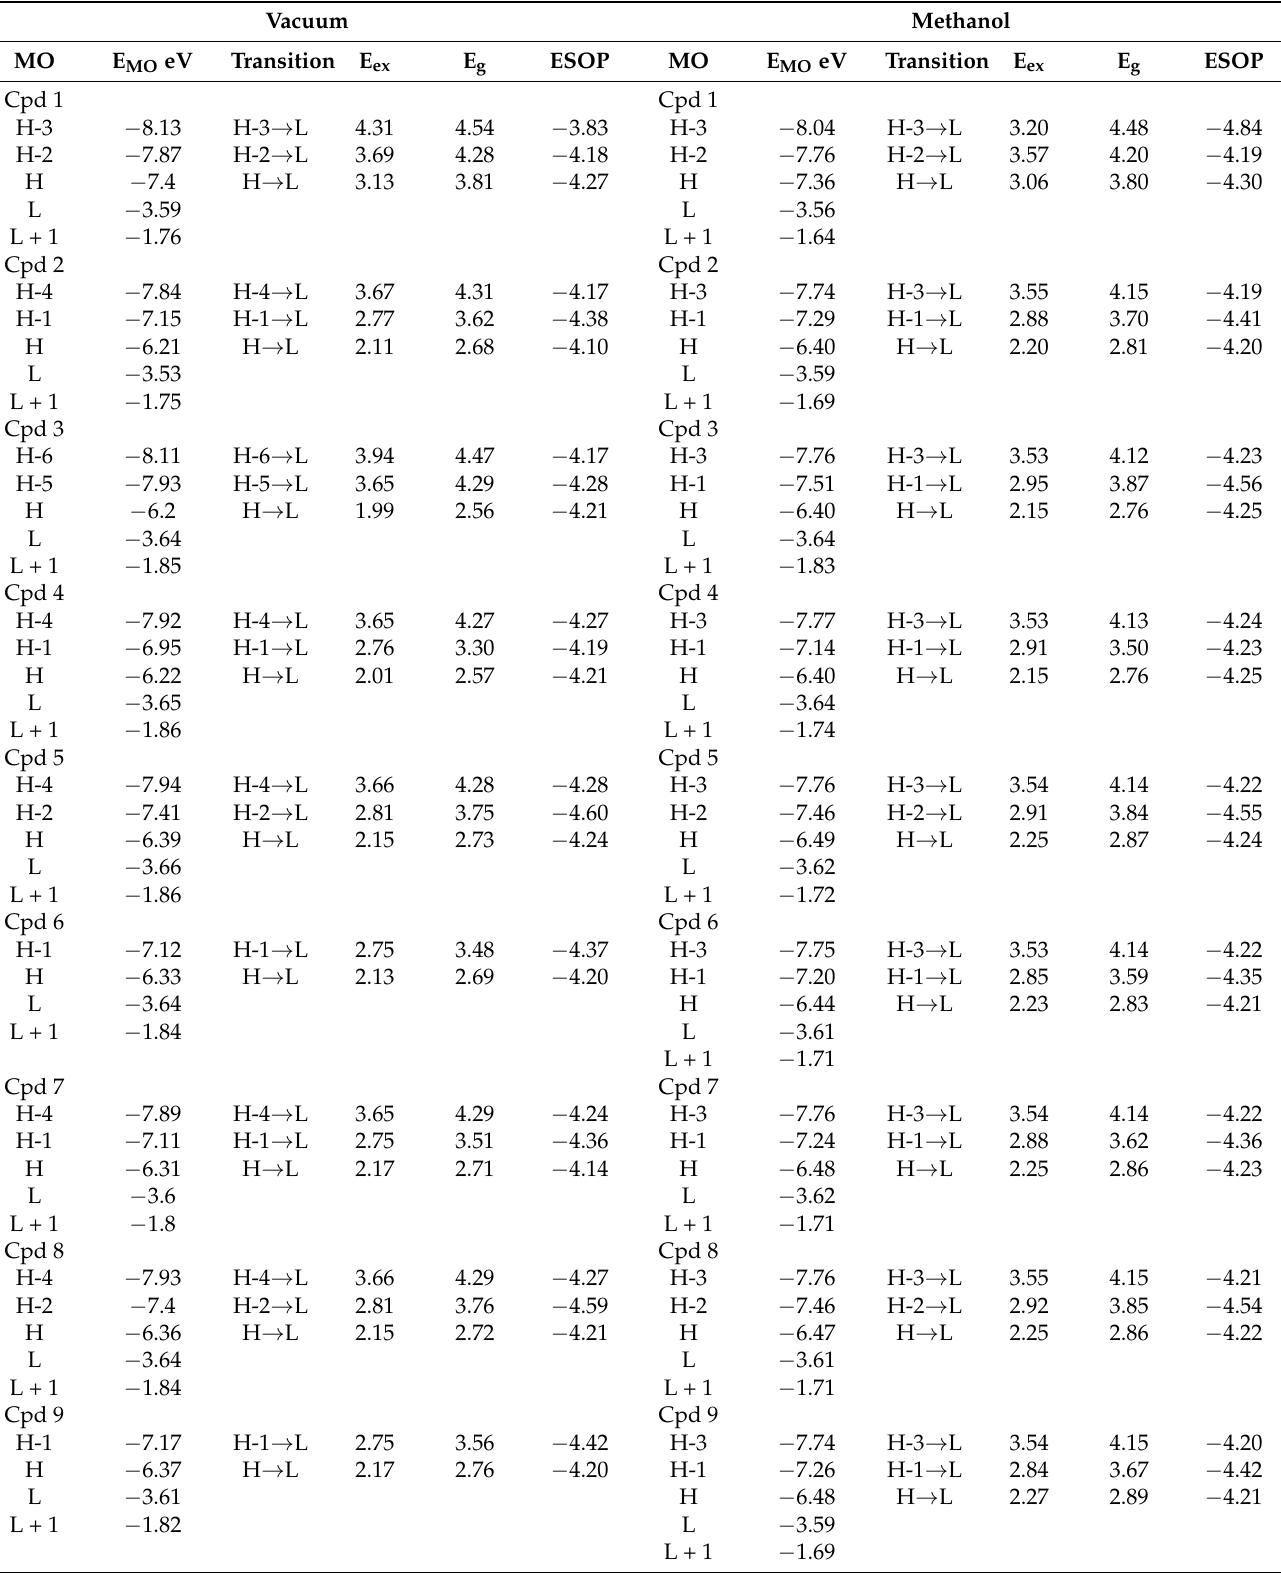
Table 5. Energies of molecular orbitals, excitation energies E ex , energy gaps E g , and excited-state oxidation potentials (ESOPs) for each relevant